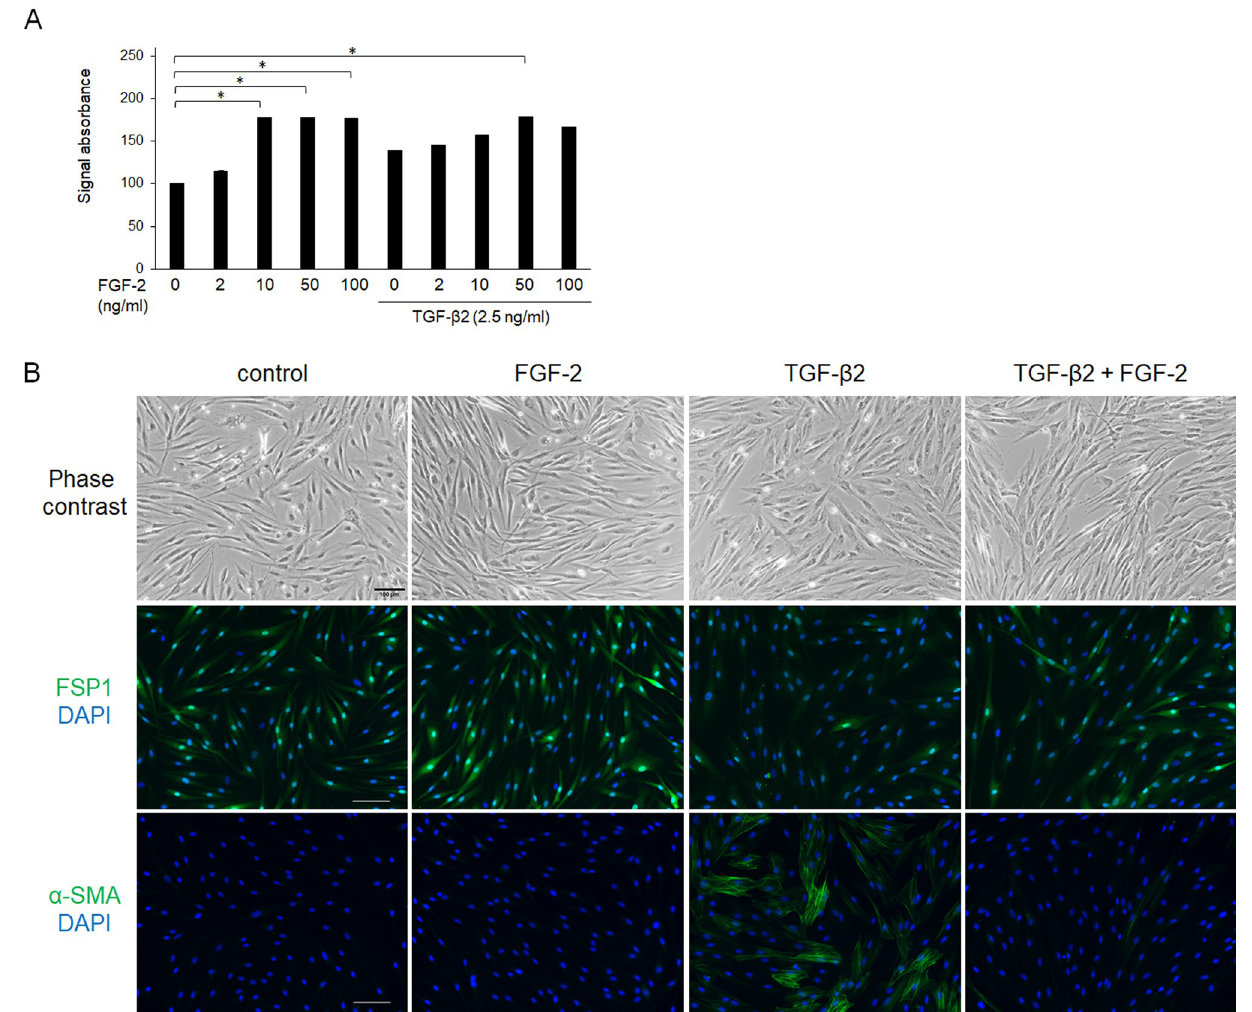
Fig 3. Effects of FGF-2 on cell proliferation (A), cell morphology, and expressions of cell-type markers (B). Conjunctival fibroblasts were treated with FGF-2 (0–100 ng/mL) in the presence or absence of 2.5 ng/mL TGF- β 2 for 48 h. Subsequently, cells were observed by phase contrast microscopy, and were subjected to the WST-8 assay or immunofluorescence assay. Both FGF-2 and TGF- β 2 increased cell proliferation without an additive effect (A). TGF- β 2 treatment induced some changes in cell shape (from spindle- to cobblestone-like); FGF-2 did not affect cell shape in the presence or absence of TGF- β 2 (B). At all conditions, cells were FSP-1 positive, while α -SMA expressed only in the cells treated with TGF- β alone. � p < 0.05. Data are shown as the mean ± SE, n = 8 for WST-8 assay, n = 3 for immunofluorescence assay. Scale bar: 200 μ m.